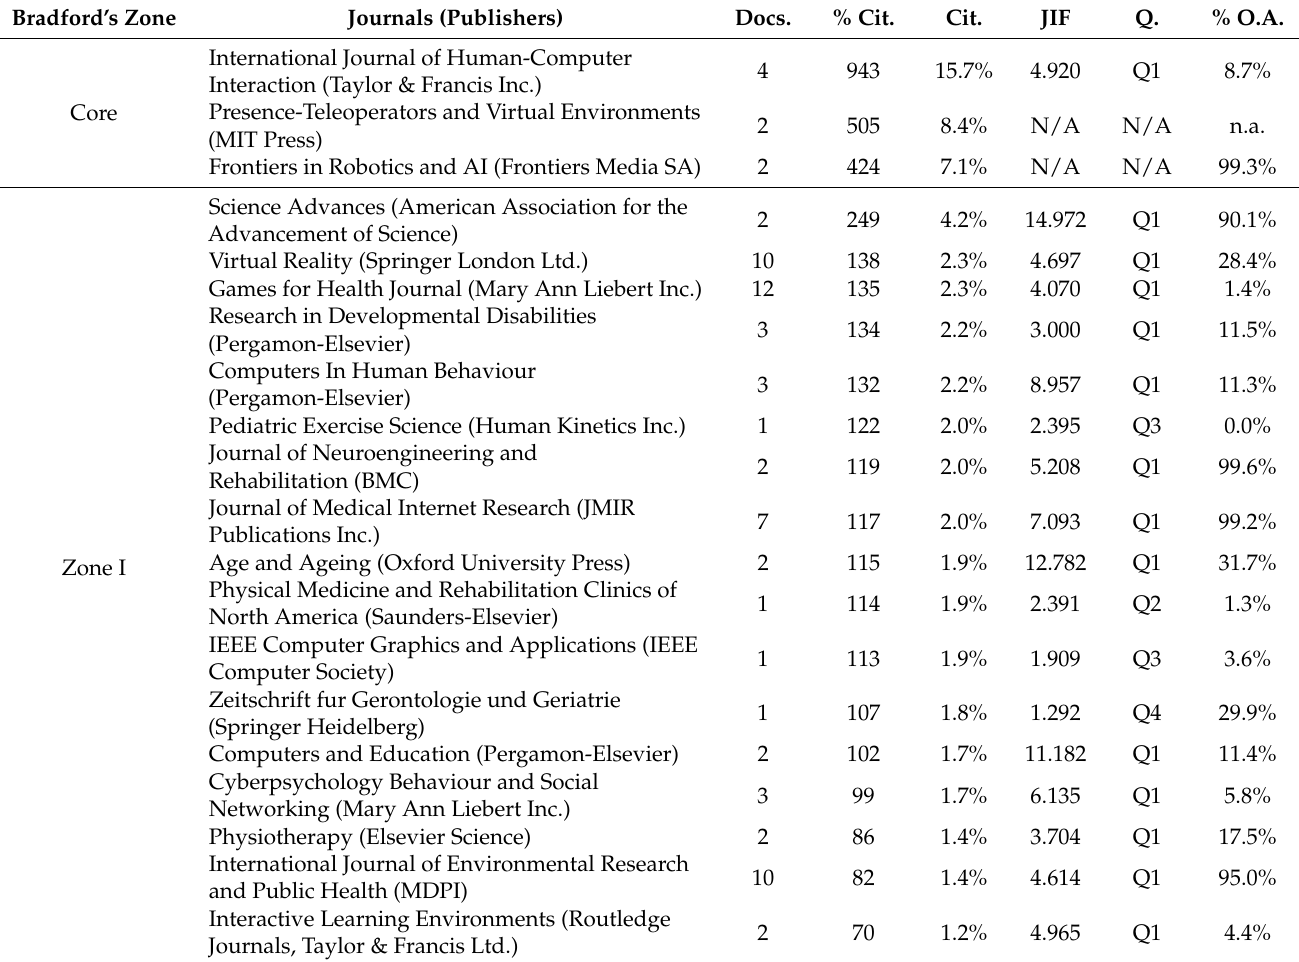
Table 2. Bradford’s Core and Zone I journals according to the number of